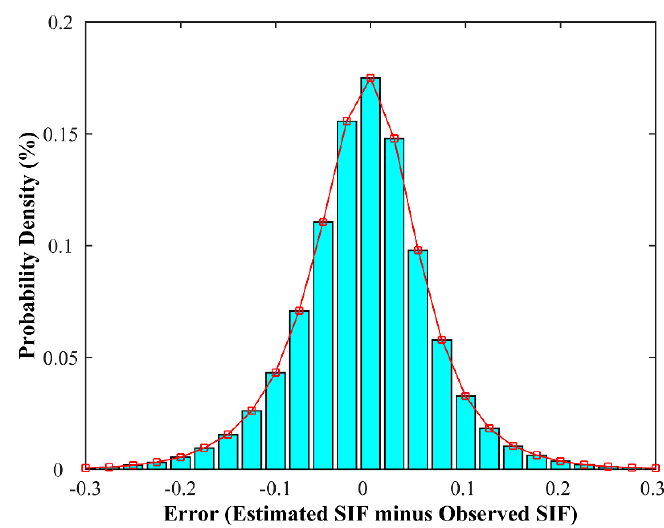
Figure 5. The probability distribution of errors (estimated SIF minus the observed SIF) in 2016.